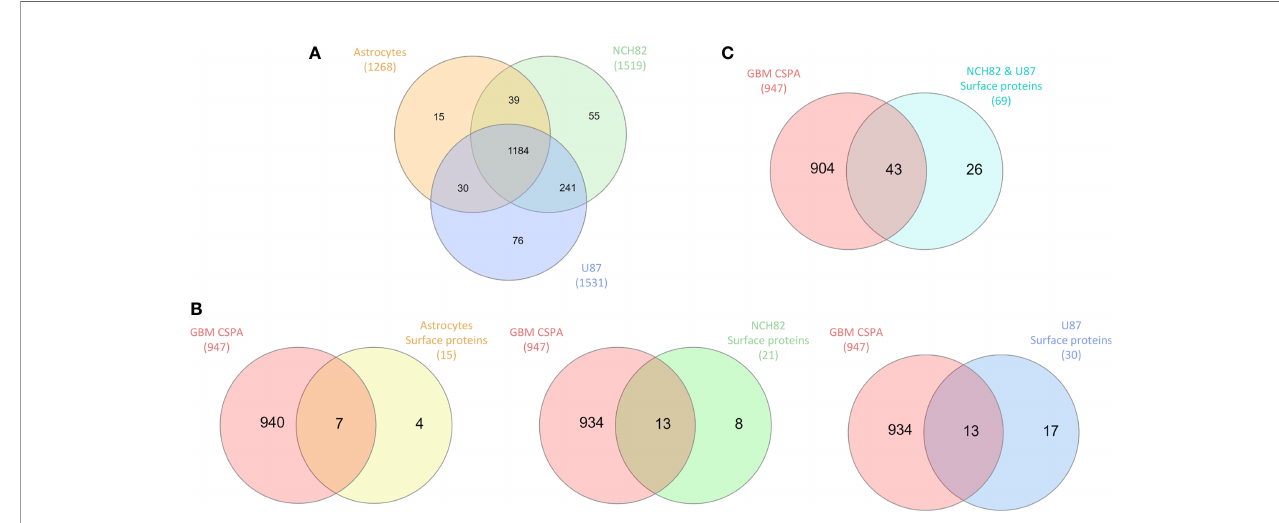
FIGURE 2 | (A) Proteins identi fi ed in all cell lines are compared in Venn diagram to highlight exclusive proteins to each cell line and common proteins to GBM cell lines. (B) Exclusive surface proteins from each cell line were compared to surface proteins from GBM cell lines in CSPA (CSPA GBM). (C) Common proteins to NCH82 and U87 GBM cell lines were compared to surface proteins from GBM cell lines in CSPA (CSPA